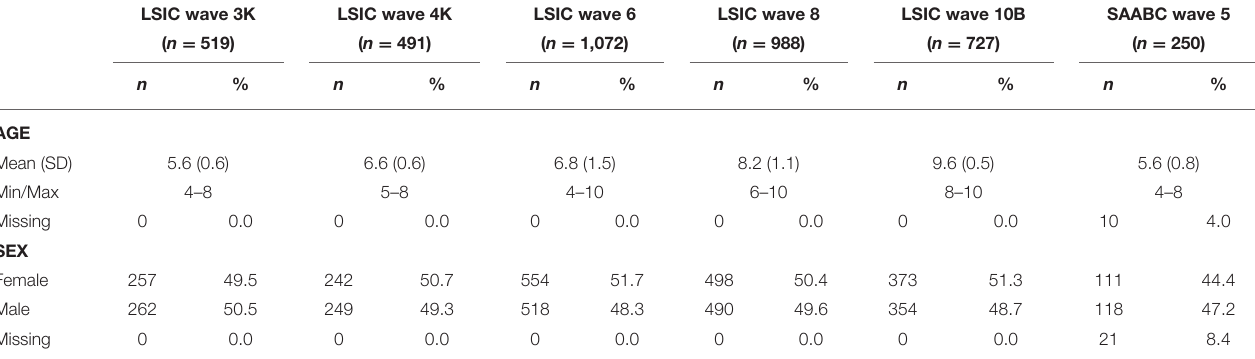
TABLE 1 | Characteristics of study